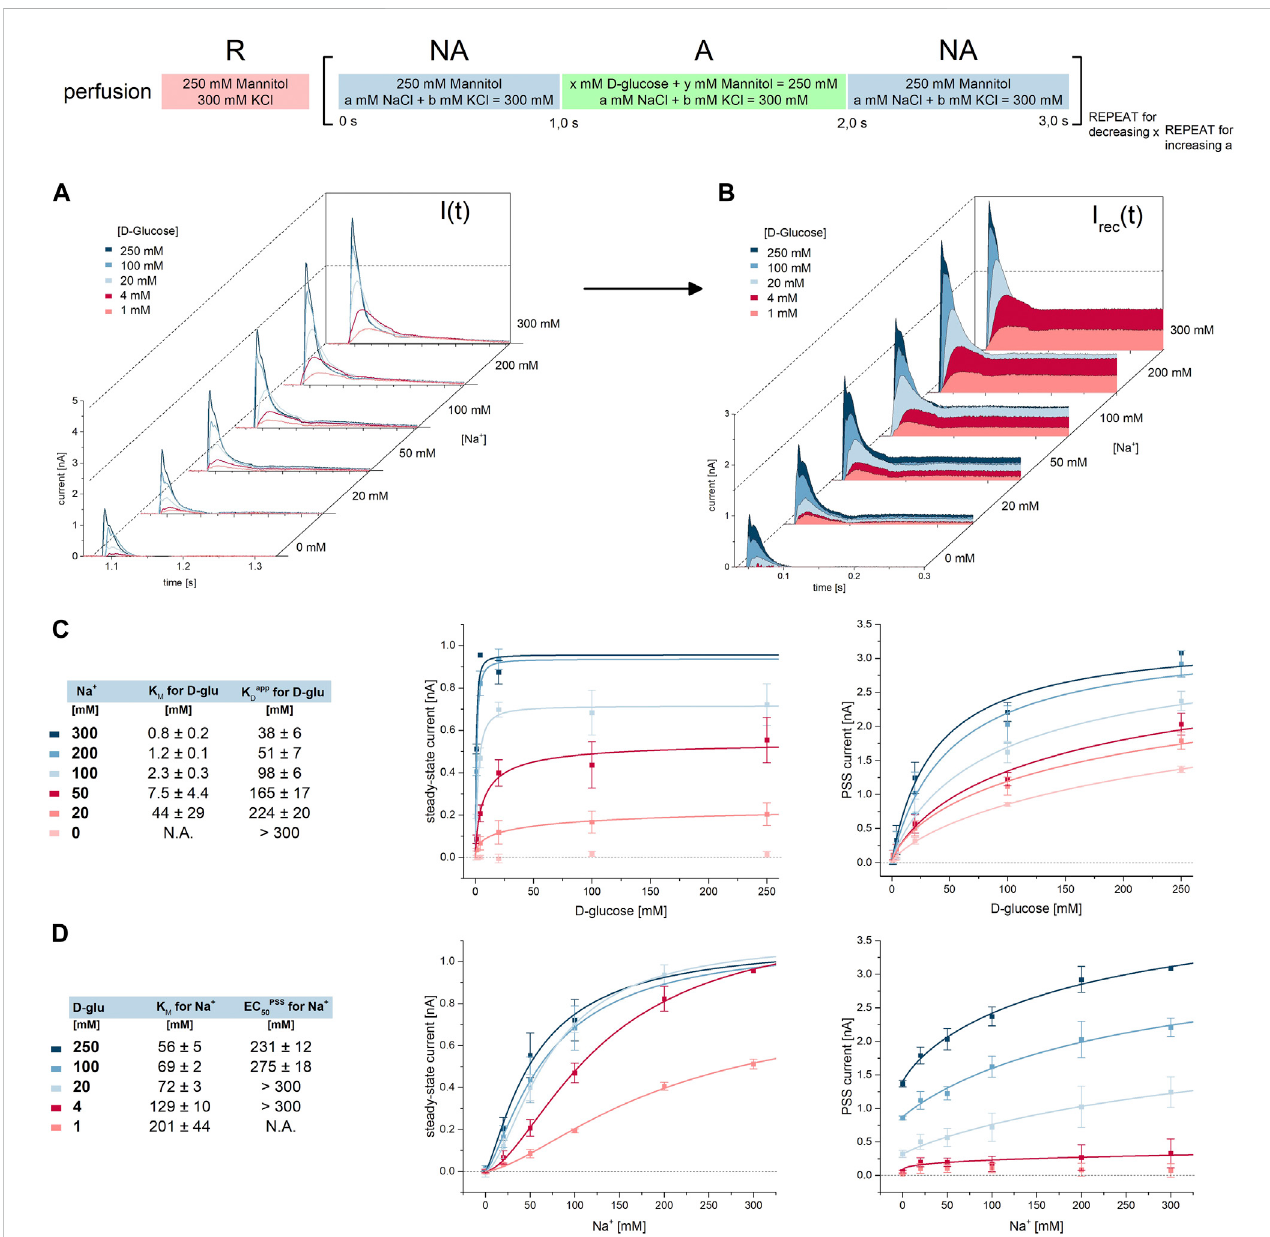
FIGURE 5 Cooperativity between D-glucose and Na + during Na + /D-glucose cotransport. All current traces were recorded on 1 mm sensors at pH 7.4 in the presence of 0 mM – 300 mM Na + in all measurement solutions and upon D-glucose concentration jumps between 1 mM and 250 mM. All 30 combinations of Na + and D-glucose concentrations were measured on the same sensor, for n = 5 sensors in total. (A) Representative current traces recorded on one sensor. D-glucose concentrations are color-coded according to the fi gure legend. One graph shows all traces for one given Na + concentration, which is indicated to the right of the graph. (B) Via circuit analysis, transporter currents were reconstructed from the current traces shown in (A) (Tadini-Buoninsegni and Fendler, 2015). Steady-state currents are used to derive K M values for D-glucose and Na + in the presence of different concentrations of co-substrate. PSS peak currents are used to derive K D app values for D-glucose and EC 50 PSS values for Na + , depending on co-substrate concentration. (C) Hyperbolic fi ts of I SS and I PSS for different D-glucose concentrations to derive K M and K D app values for D-glucose in the presence of different Na + concentrations. (D) Hyperbolic fi ts of I SS and I PSS for different Na + concentrations to derive K M and EC 50 PSS values for Na + in the presence of different D-glucose